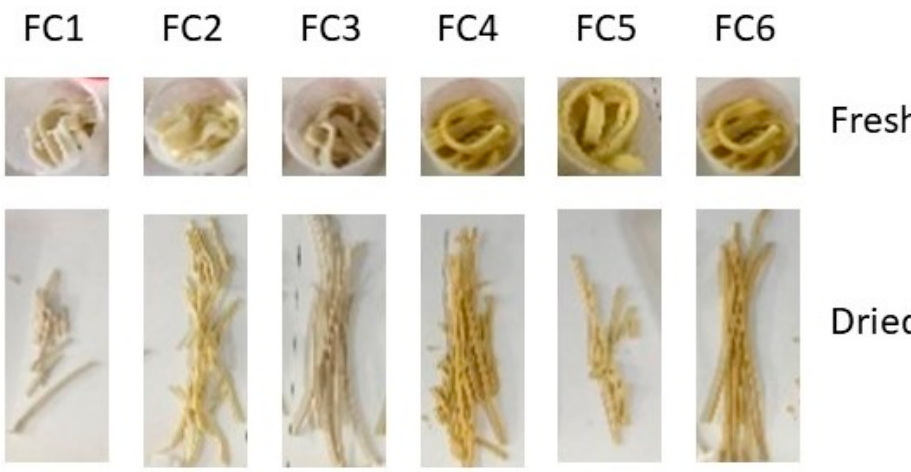
Figure 2. Preliminary pasta samples: fresh and dried.